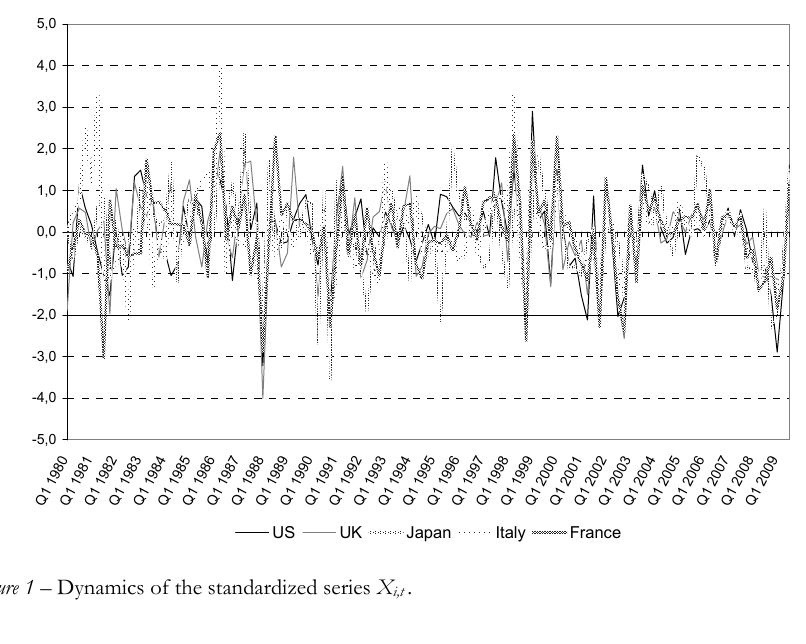
Figure 1 – Dynamics of the standardized series X i,t .